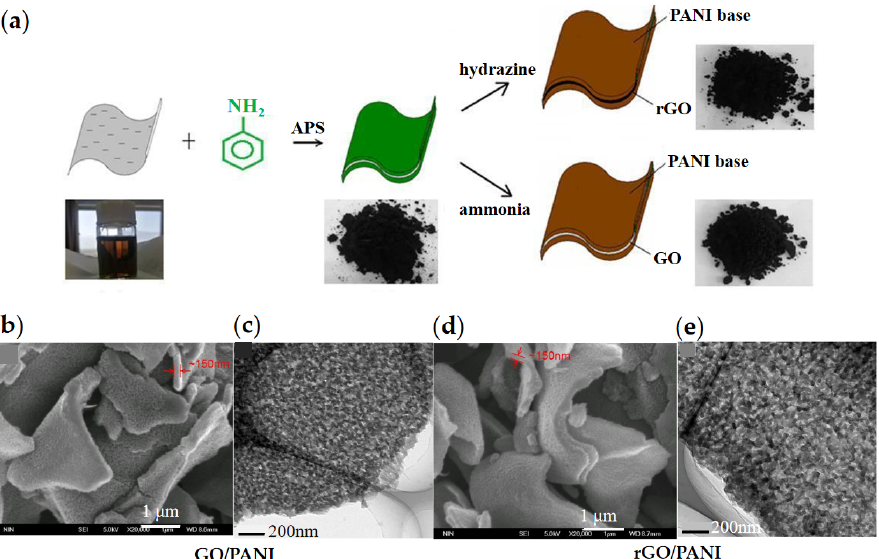
Figure 6. ( a ) Schematic preparation of GO/PANI by in situ polymerization of aniline on the surface of GO and the resulting rGO/PANI by hydrazine treatment of GO/PANI [85]; ( b – e ) SEM and TEM images of GO/PANI and rGO/PANI [83], both are ~150 nm thick.